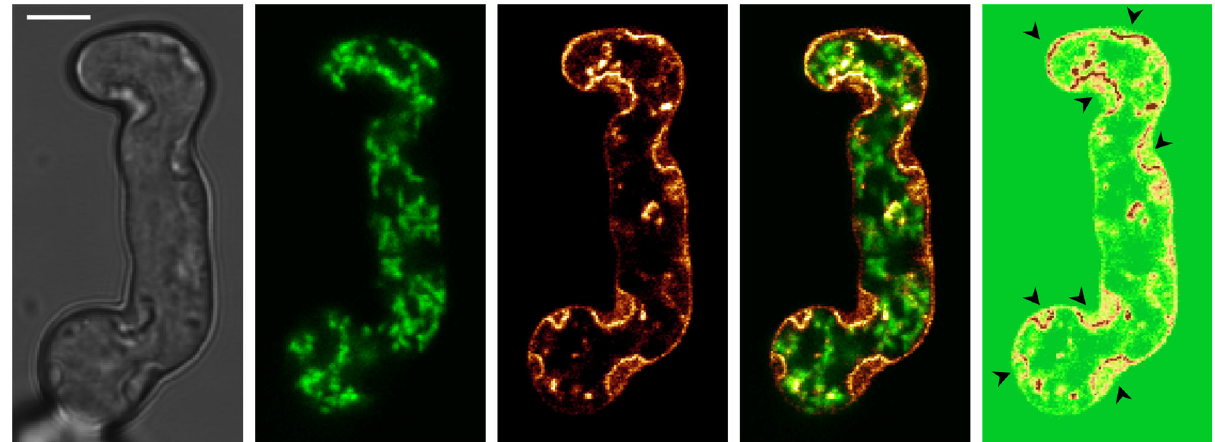
Fig. 4 Multiple azole-induced cell wall carbohydrate patches invaginate the plasma membrane. A . fumigatus conidia expressing mitochondria-targeted red fl uorescence protein (RFP) and GFP-tagged membrane-anchored Wsc1 were inoculated in Sabouraud medium. After 9 h incubation at 37 °C, medium was supplemented with 0.53 µ g ml − 1 voriconazole. Fluorescence was analyzed with a confocal laser scanning microscope. The micrographs show bright fi eld (left), fl uorescence cross sections (green, RFP; glow dark color scheme, GFP) and an overlay of the two fl uorescence cross sections of a representative hypha incubated for 4 h in the presence of voriconazole. The GFP fl uorescence intensity is additionally visualized with a heatmap color scheme (right micrograph), the accumulation of Wsc1-GFP at sites of plasma membrane invaginations are indicated with arrow heads. The bar represents 5 μ m